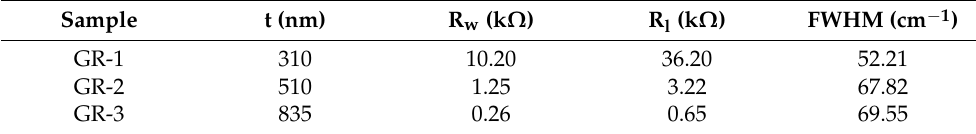
Table 1. Physical parameters for the synthesized graphite